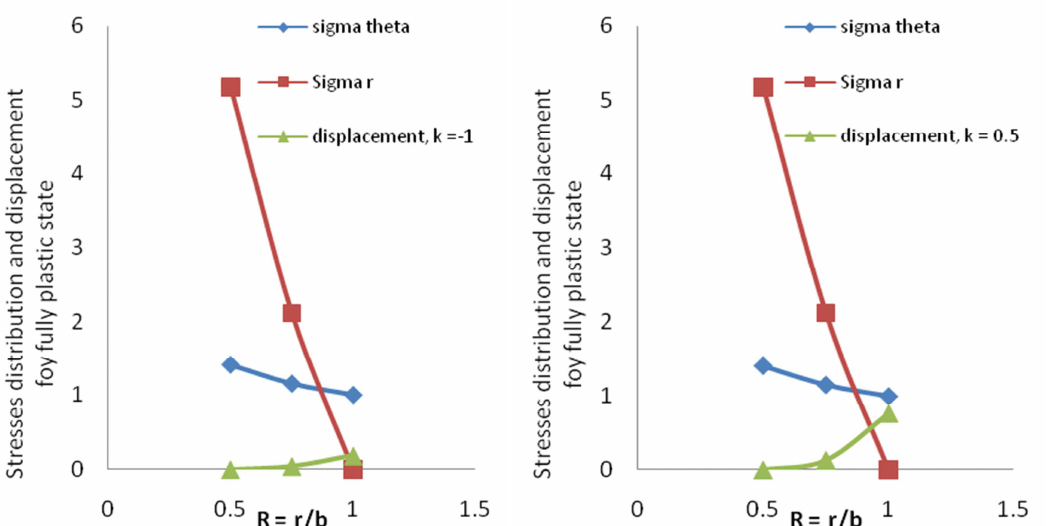
Figure 4. Stresses and Displacement for fully-plastic state of rotating disc along the radius R = r / b